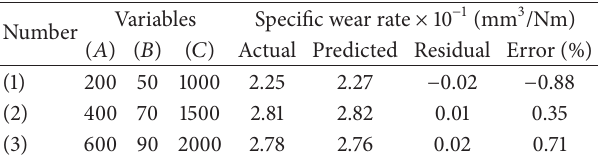
Table 5: The results of conformation